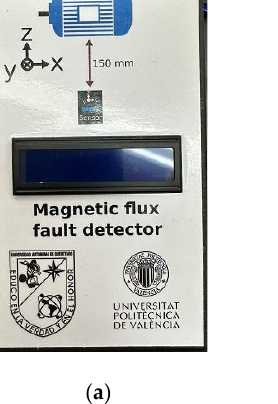
Figure 6. FPGA-based proprietary SMFD: ( a ) physical system; ( b ) hardware components.